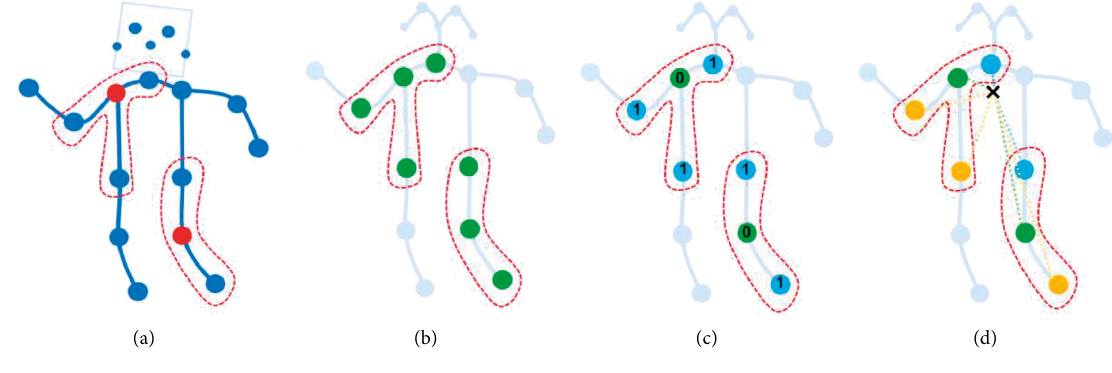
Figure 2: Three partition